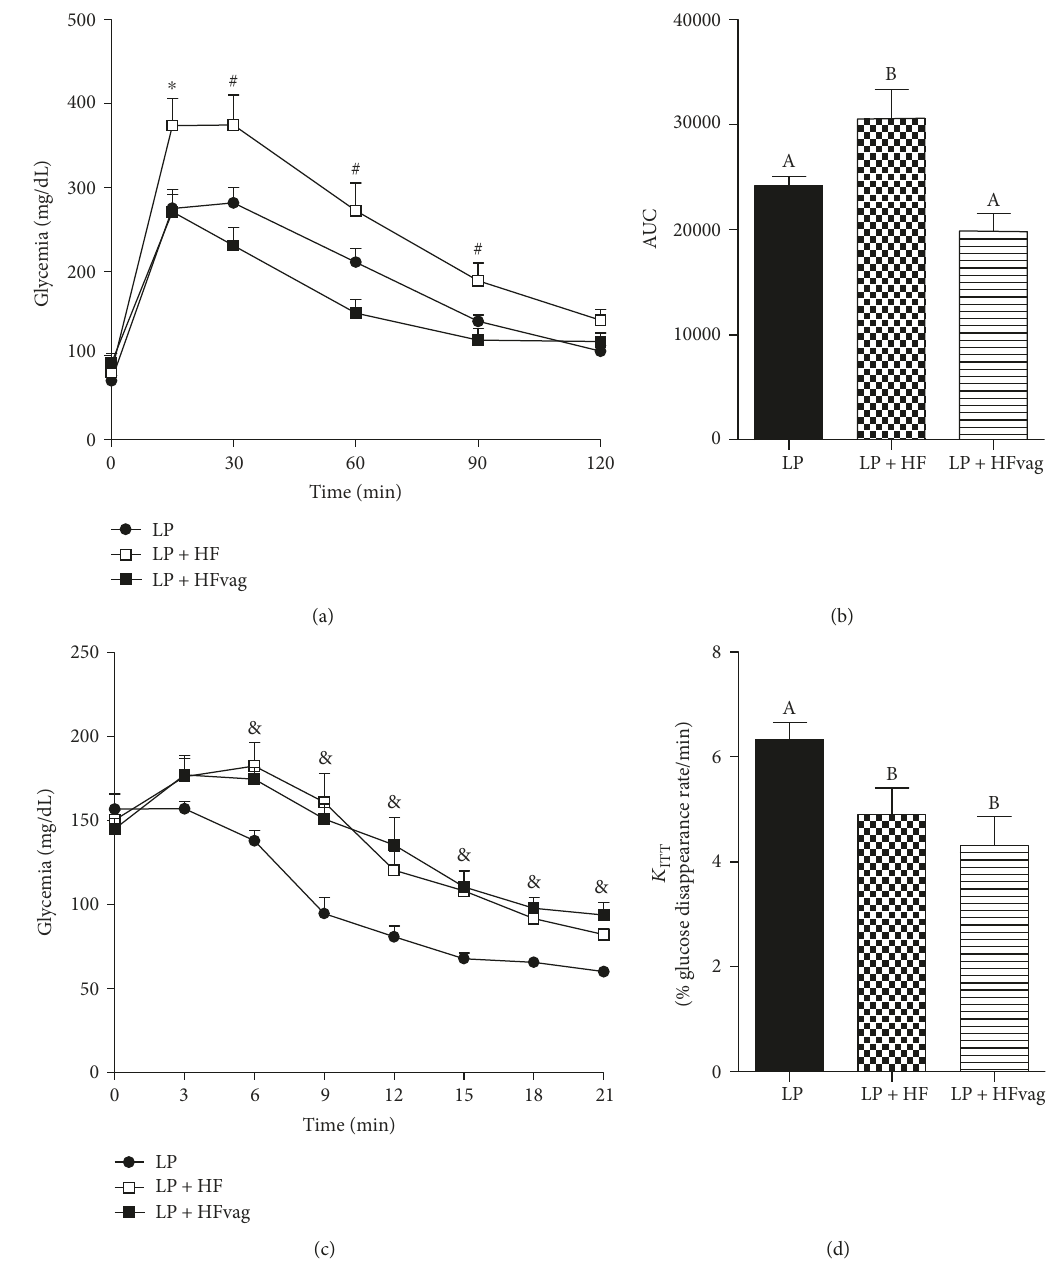
Figure 1: Vagotomy improved glucose tolerance but not insulin sensitivity. Blood glucose during the ipGTT (a) and its respective area under curve (AUC) (b). Blood glucose during ipITT (c) and glucose disappearance rate ( K ) (d) in the LP, LP +HF, and LP + HFD mice. Data are ITT means ± SEM from LP ( n = 11 – 13 ); LP + HF ( n = 8 – 10 ); LP +HFvag ( n =5-6). The symbols “ ∗ ” indicate signi fi cant di ff erences between the LP and LP +HFvag compared to the LP +HF; “ #, ” between the LP +HF and LP +HFvag; and “ &, ” between the LP +HF and LP +HFvag compared to the LP. Di ff erent letters over the bars indicate signi fi cant di ff erences. One-way ANOVA followed by Tukey ’ s test. P < 0 05